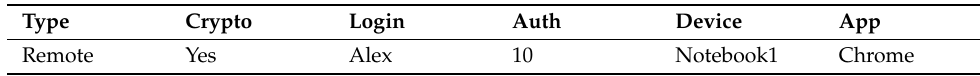
Table 15. Example of query results of the algorithm for Feature